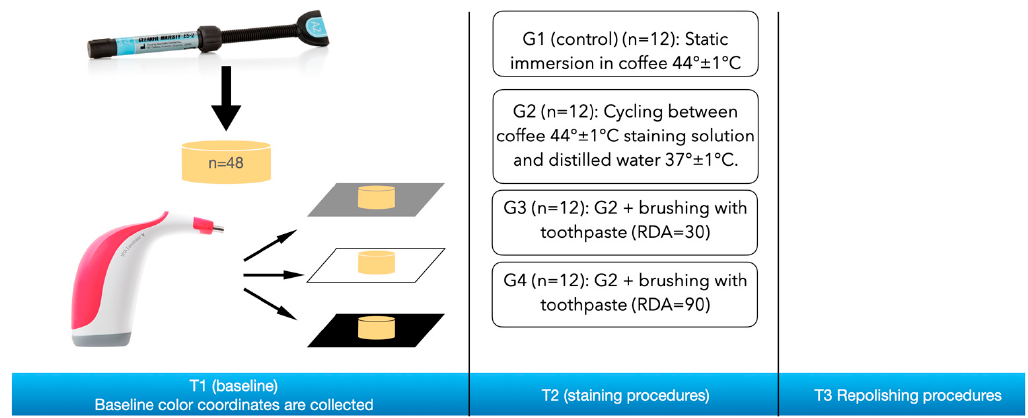
Figure 4. Graphical representation of the experimental design.